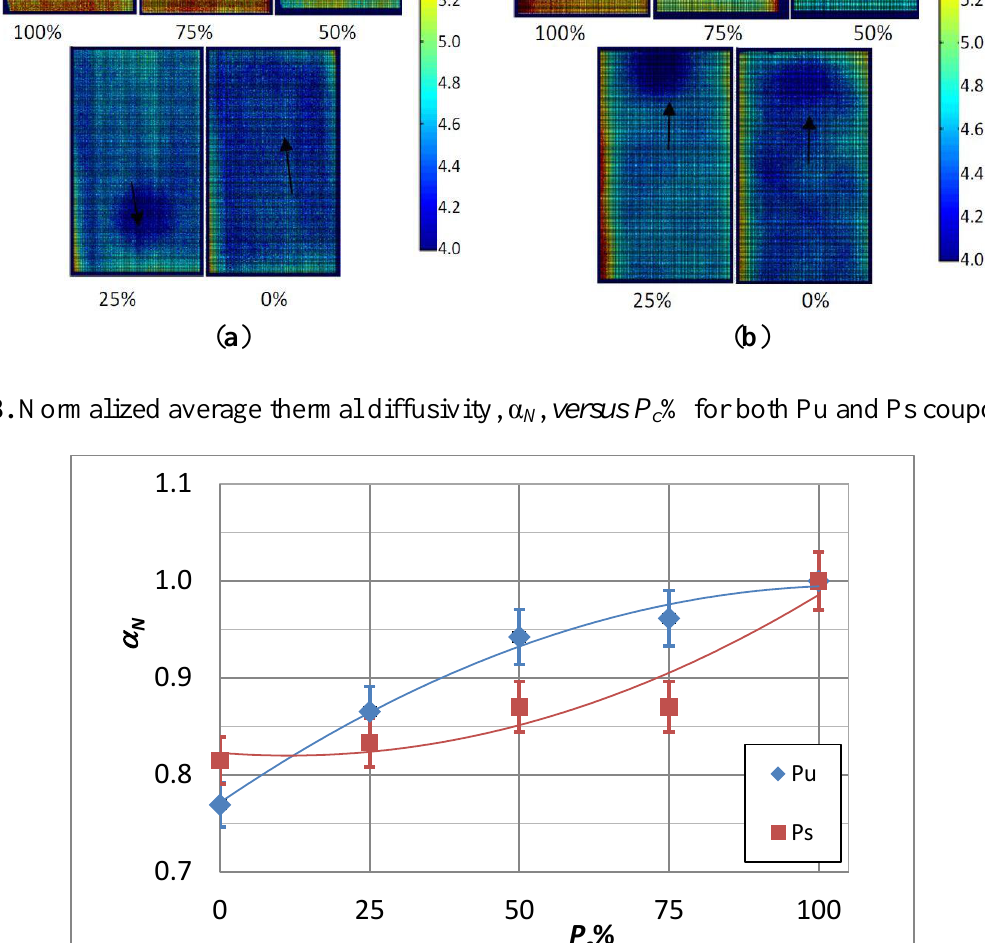
Figure 7. Thermal diffusivity maps. ( a ) Pu-type coupons; ( b ) Ps-type coupons. An arrow indicates the position of the Kapton disk in each map.